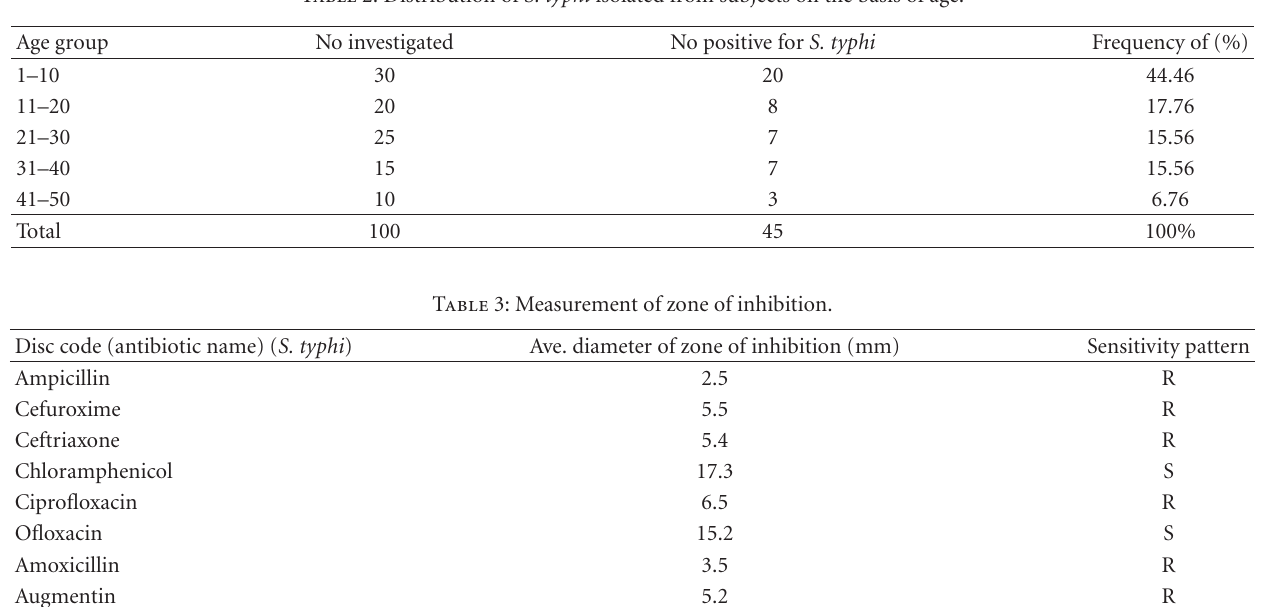
Table 2: Distribution of S. typhi isolated from subjects on the basis of age.